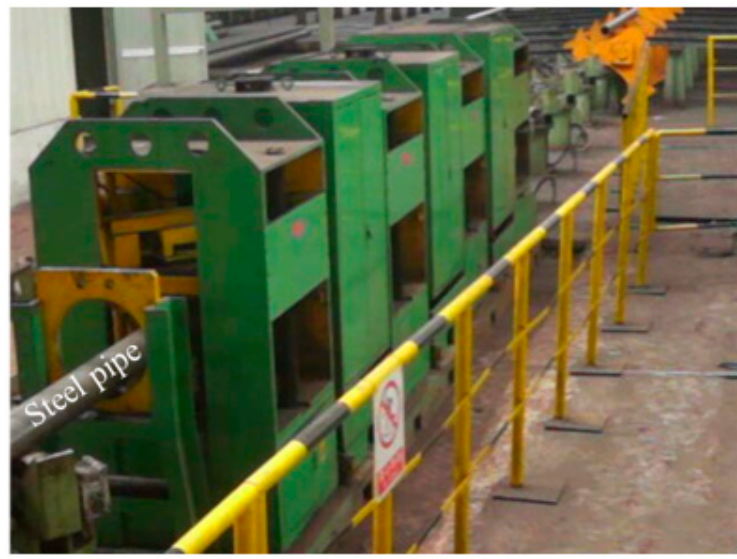
Figure 10. The MFL probing system for steel pipe.